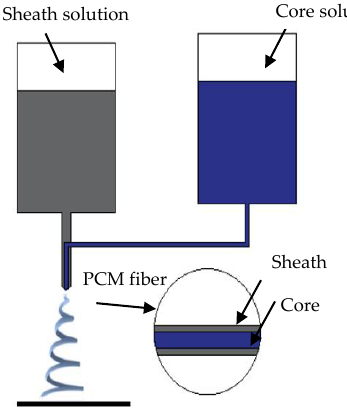
Figure 1. Co-axial electrospinning set up.